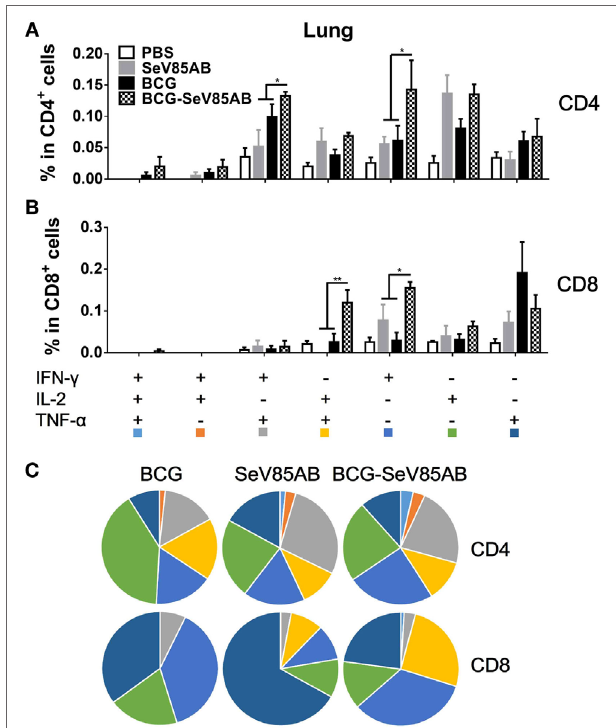
FigUre 5 | Characterizations of poly-functional Ag85AB-specific T cell responses in the lung. T cells secreting IFN- γ , IL-2, and TNF- α were distinguished as seven distinct subpopulations as described in Figure 3 . The percentage of subpopulation as components of the total CD4 + (a) and CD8 + (B) T cell populations and the pie chart analysis (c) are shown. Significant differences in frequency of poly-functional T cell subsets are indicated. Data are representative of two independent experiments with at least four mice per group. * P < 0.05 and ** P <